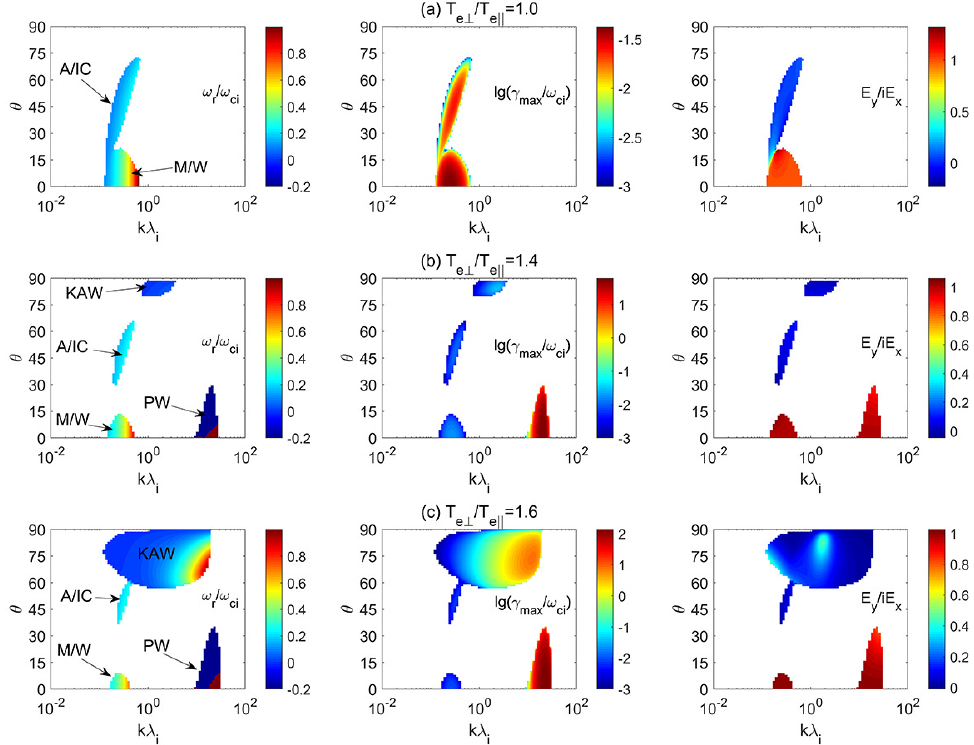
Figure 9. Color bar distributions of the real frequency ( ω r / ω ci ), maximum growth rate ( γ max / ω ci ), and polarization ( E y / iE x ) in the plane of k λ i and θ for ( a ) T e ⊥ / T e (cid:107) = 1, ( b ) 1.4, and ( c ) 1.6 in a plasma with high beta β e (cid:107) = 2. The alpha beam drift velocity v α / v A = 2 was used.